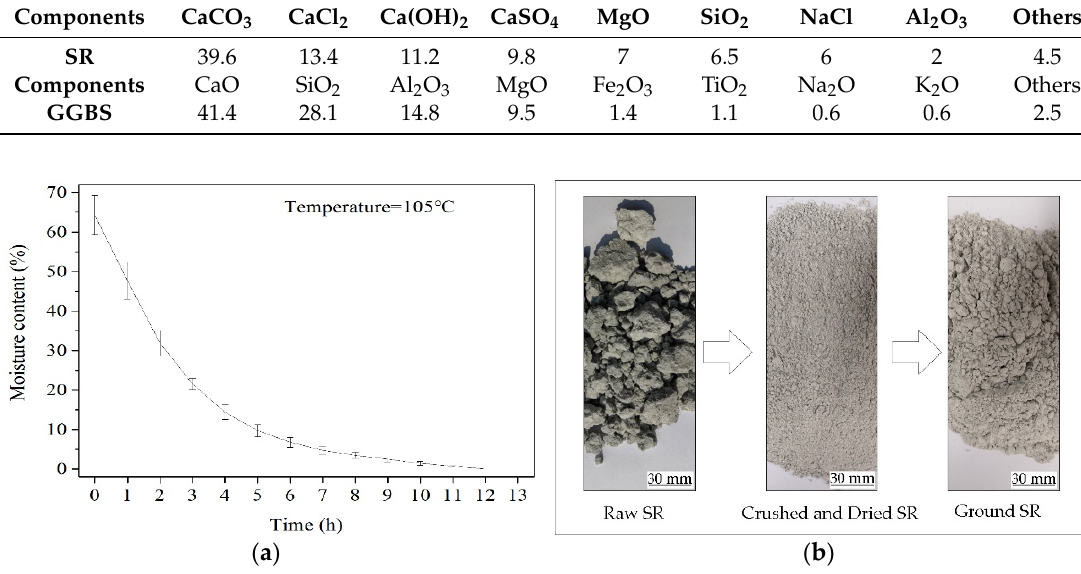
Figure 1. Moisture content of SR ( a ) and flow chart of SR pretreatment ( b ).